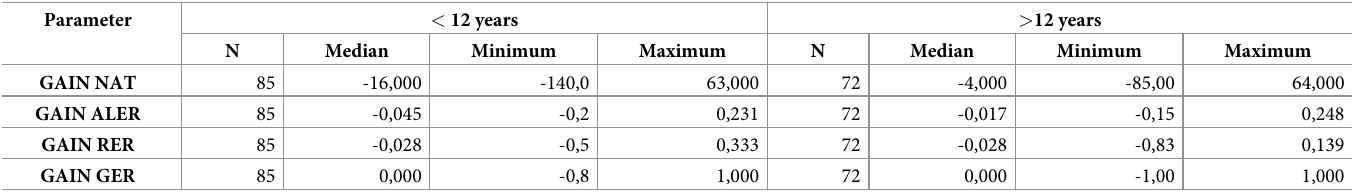
Table 7. Descriptive statistics of multisensory gain in all parameters below and above 12 years of age. The conventions are the same as in Figs 3 and 4.